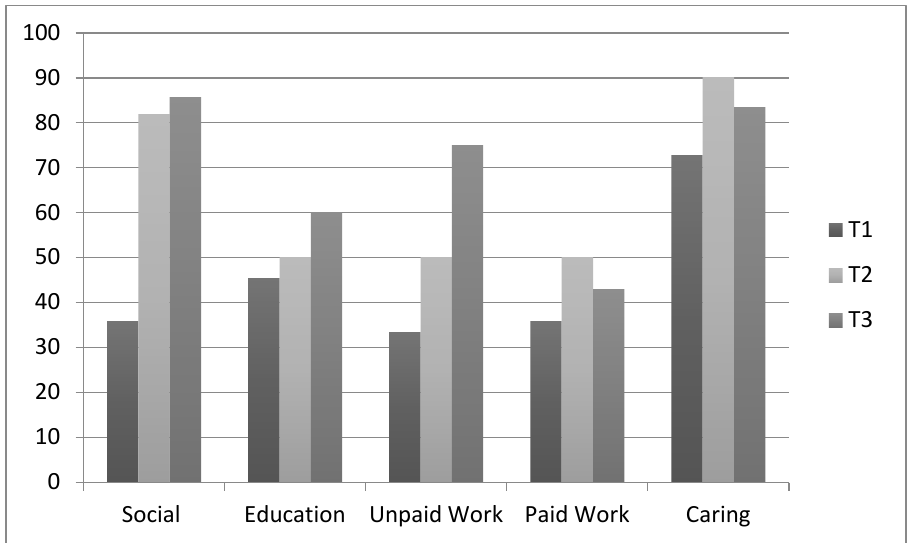
Figure 2. Proportion of consumers perceiving their participation as ‘About Right’.